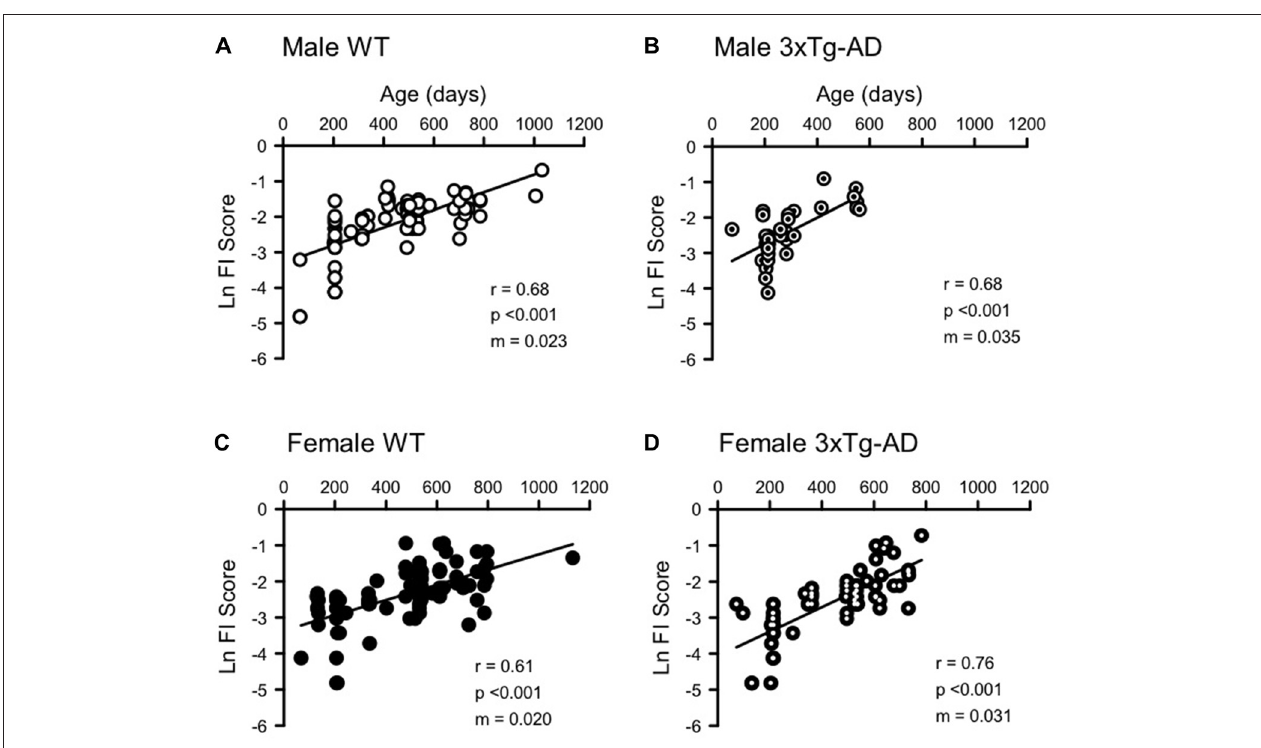
FIGURE 2 | Natural log frailty index (FI) scores increase with age in male and female 3xTg-AD and WT mice. Ln FI Score was correlated with age for (A) WT males ( n = 84, r = 0.681, p < 0.0001), (B) 3xTg-AD males ( n = 35, r = 0.677, p < 0.0001), (C) WT females ( n = 91, r = 0.608, p < 0.0001) and (D) 3xTg-AD females ( n = 62, r = 0.755, p < 0.0001). The slope of the linear regression line (m, shown on each graph) is equivalent to the rate of deficit accumulation and is 0.023, 0.035, 0.020 and 0.031 for male WT, male 3xTg-AD, female WT and female 3xTg-AD respectively. A larger slope indicates a faster accumulation of